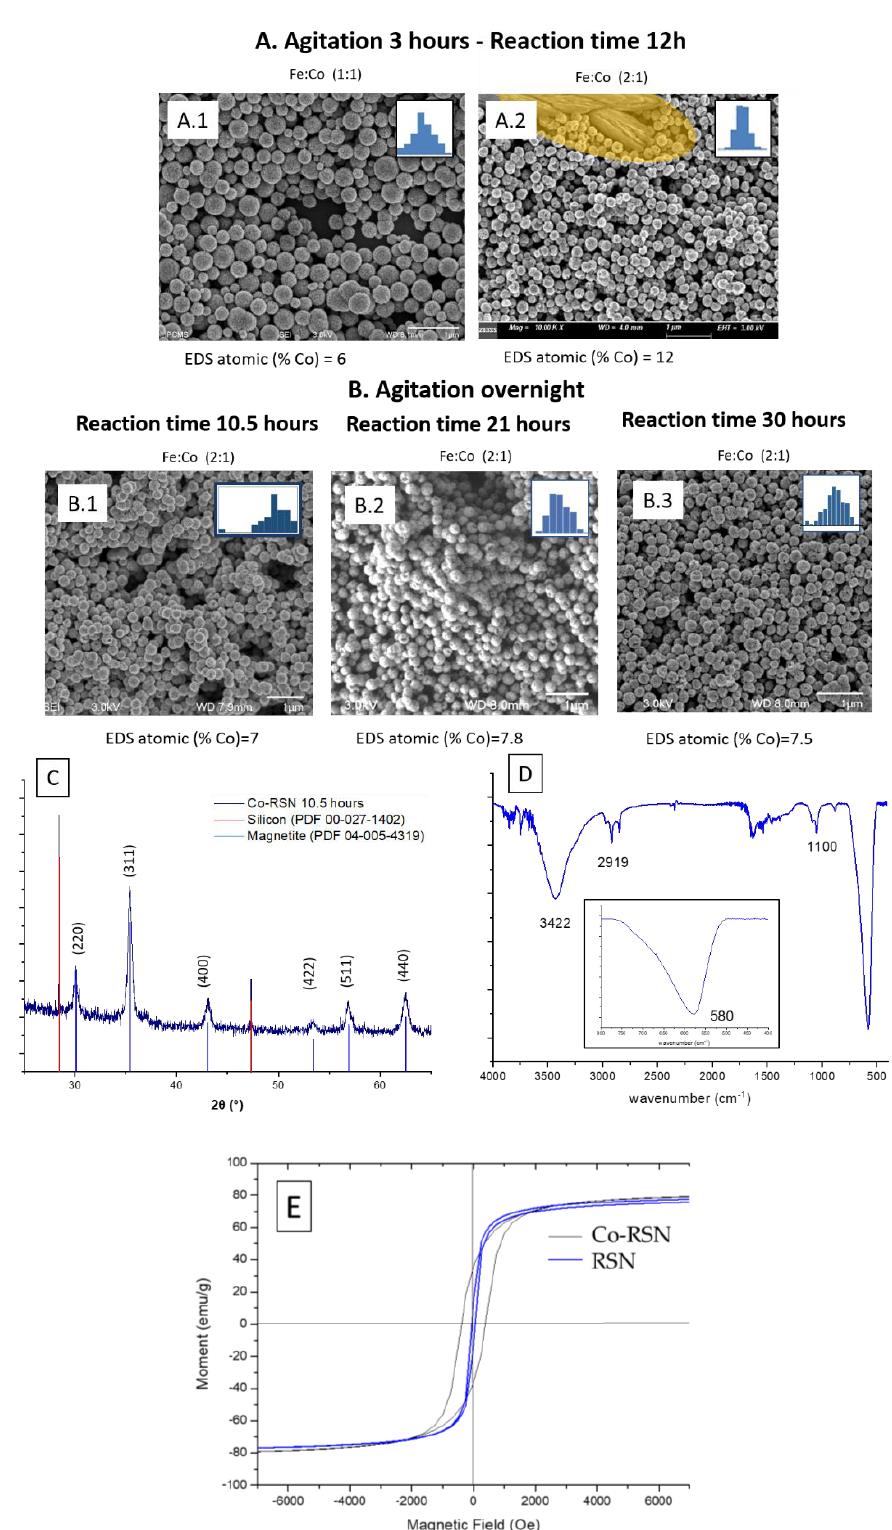
Figure 4. SEM images of cobalt-doped RSNs. ( A ) Experiments with 3 h mixing (golden shading in A2 shows the carbonate particles and inner images = SEM size distribution). ( B ) Experiments with overnight mixing. ( C ) XRD pattern. ( D ) FTIR spectrum (inner image = zoom on Fe – O bands showing one band at 580 cm − 1 characteristic of the magnetite phase). ( E ) Magnetization curves of the undoped and cobalt-doped (B.1) RSN at 300 K.